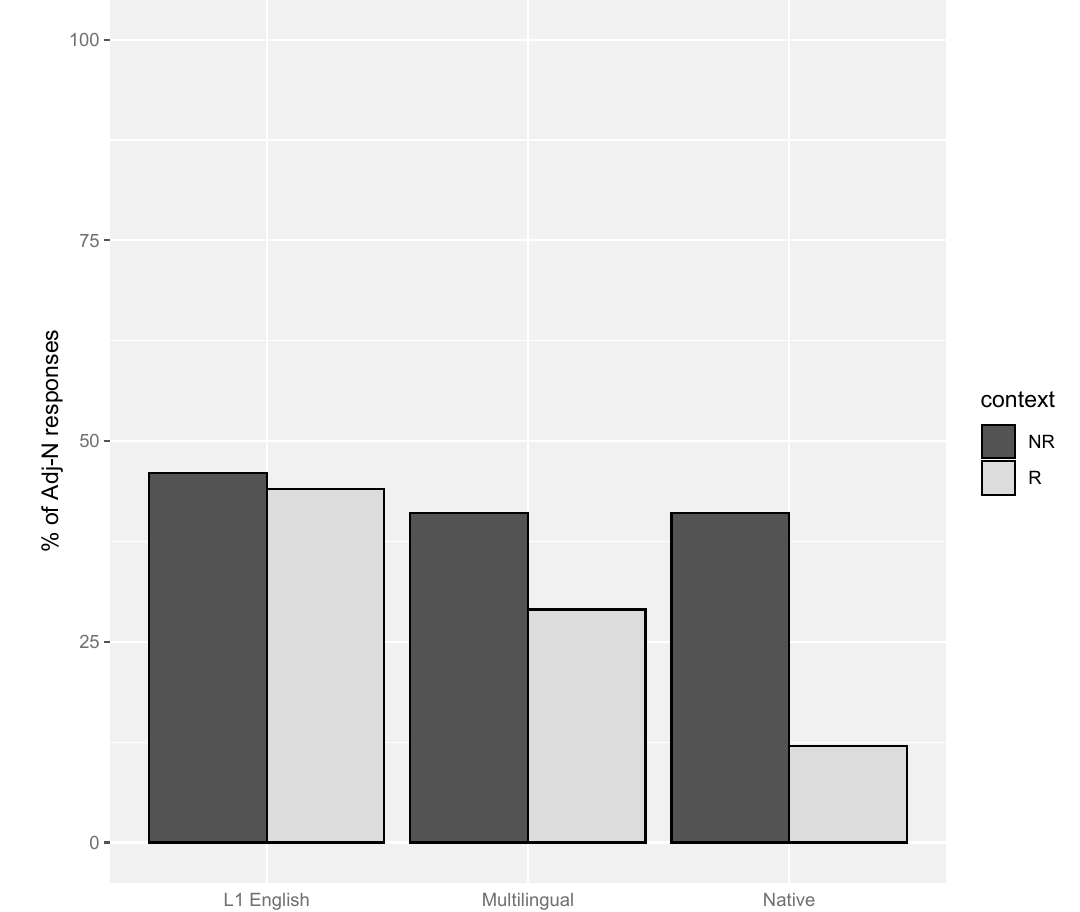
Figure 1. Percentage of adjective–noun (Adj–N) response given for NR and R contexts by speaker group (L1 English, Multilingual, Native).